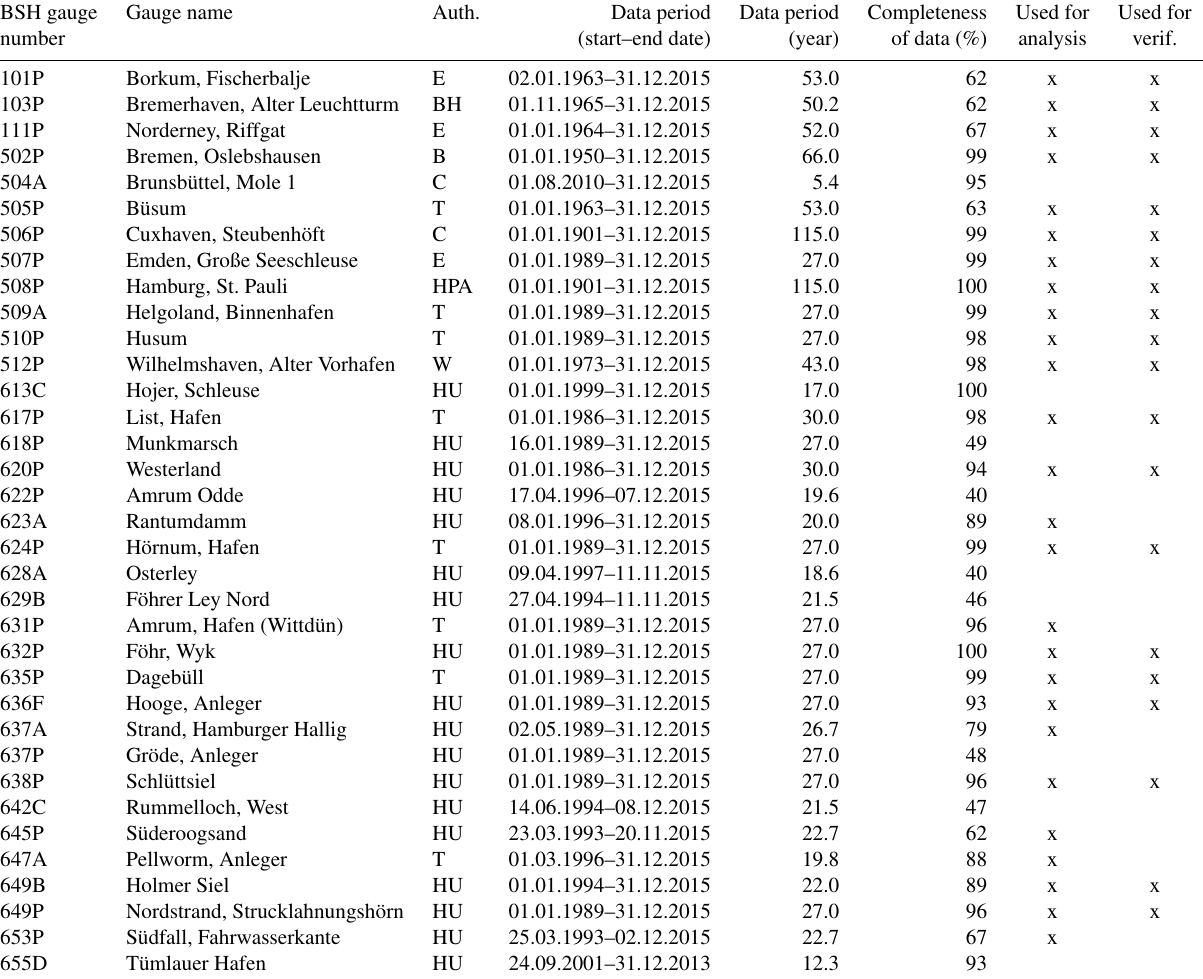
Table A1. 137 German tide gauges which deliver water level observations on a regular basis and for which tidal predictions were published in BSH tide tables ( Gezeitentafeln ) or the tide calendar ( Gezeitenkalender ) for the year 2018. The data from the tide gauges are observed times and heights of high and low water. The tide gauges are operated by different federal and state agencies which provide tide gauge records to BSH. Abbreviations in the third column correspond to the following agencies: E: Emden Waterways and Shipping Authority